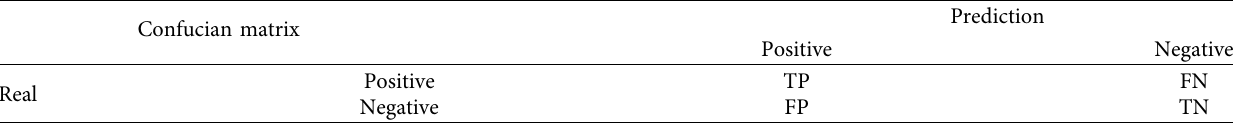
Table 5: Confucian matrix.